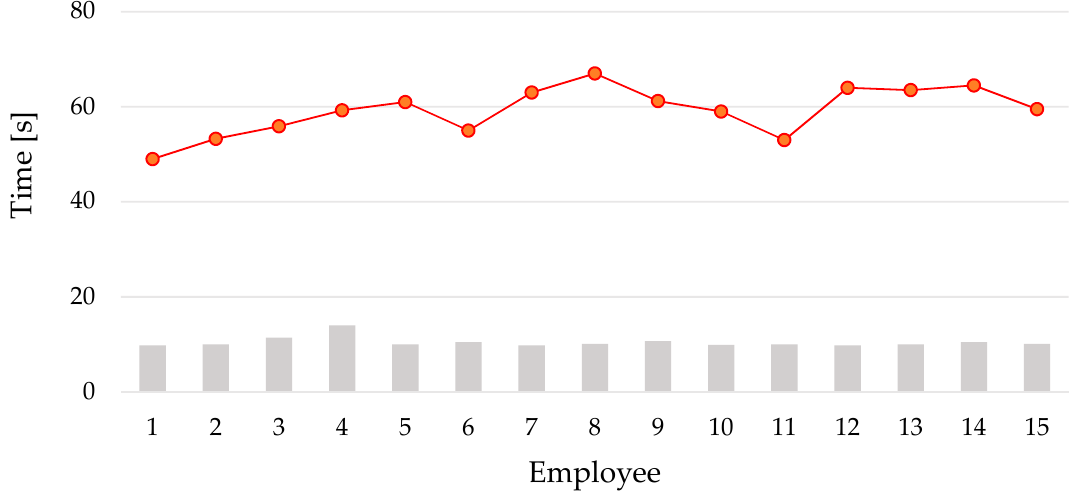
Figure 5. Time distribution after reducing the tag system.